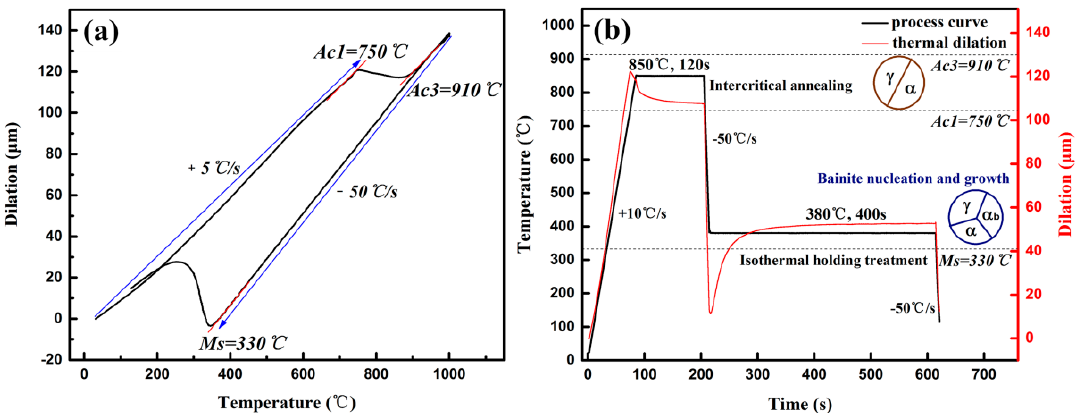
Figure 1. Schematic diagram of ( a ) phase transformation points and ( b ) optimal heat treatment condition carried out on a thermal dilatometer.